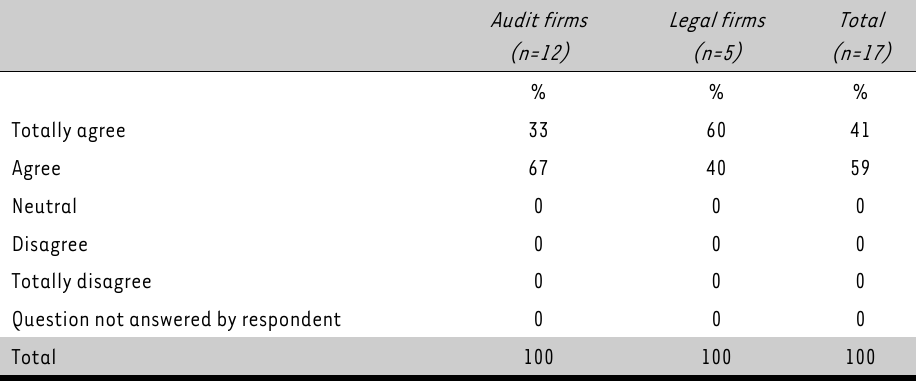
TABLE 12: Results of question 4.4.10